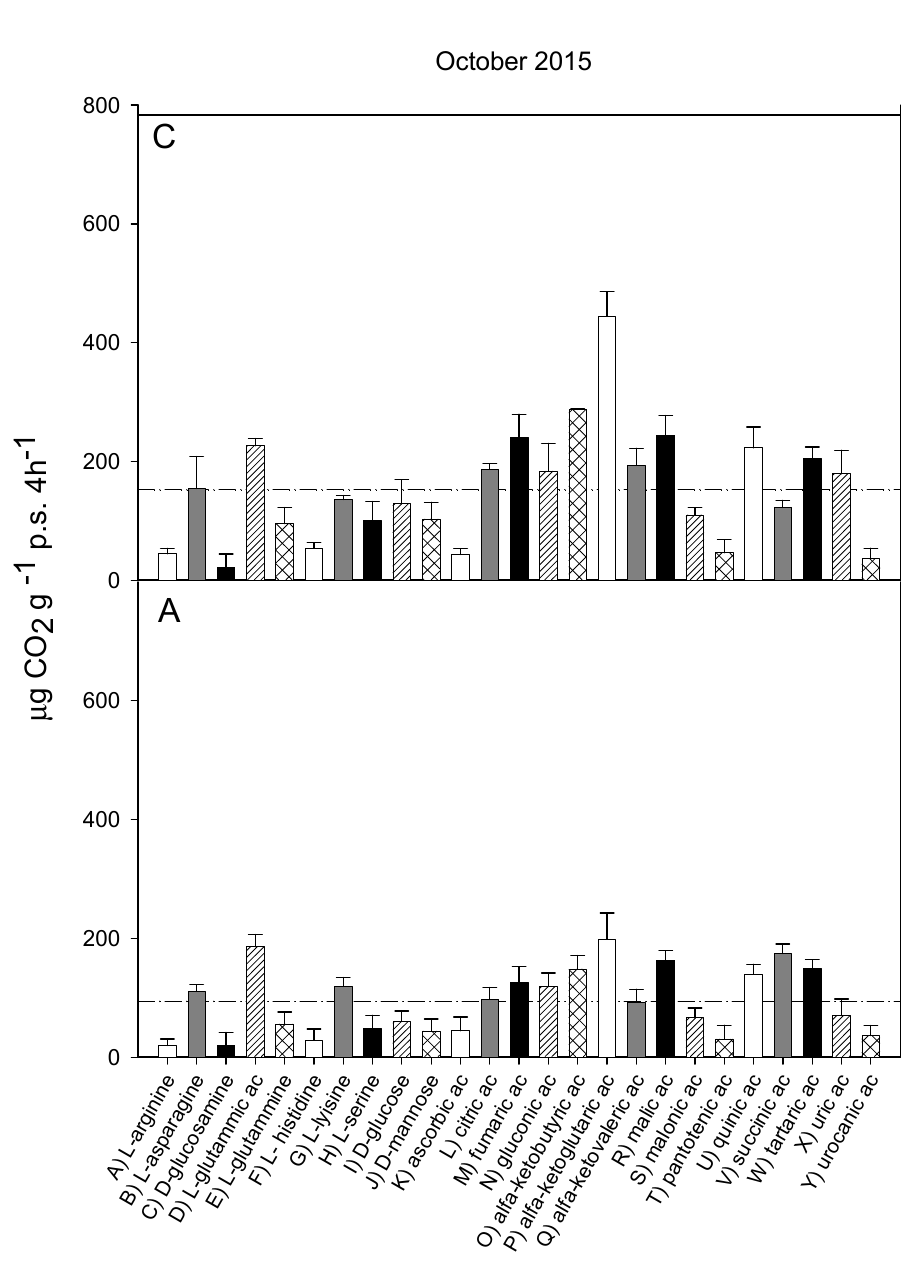
Figure 4. Catabolic response profile of chestnut ( C ) and agricultural ( A ) soils in October 2015. The dotted line represents the average substrate-induced respiration (ASIR), corresponding to 152.8 ± 17.9 in chestnut and to 93.99 ± 19.3 in agricultural soil (the values were significantly different with p < 0.05).